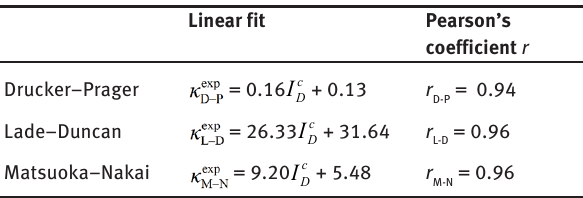
Table 5: The linear fits κ exp ( correlation coefficients.